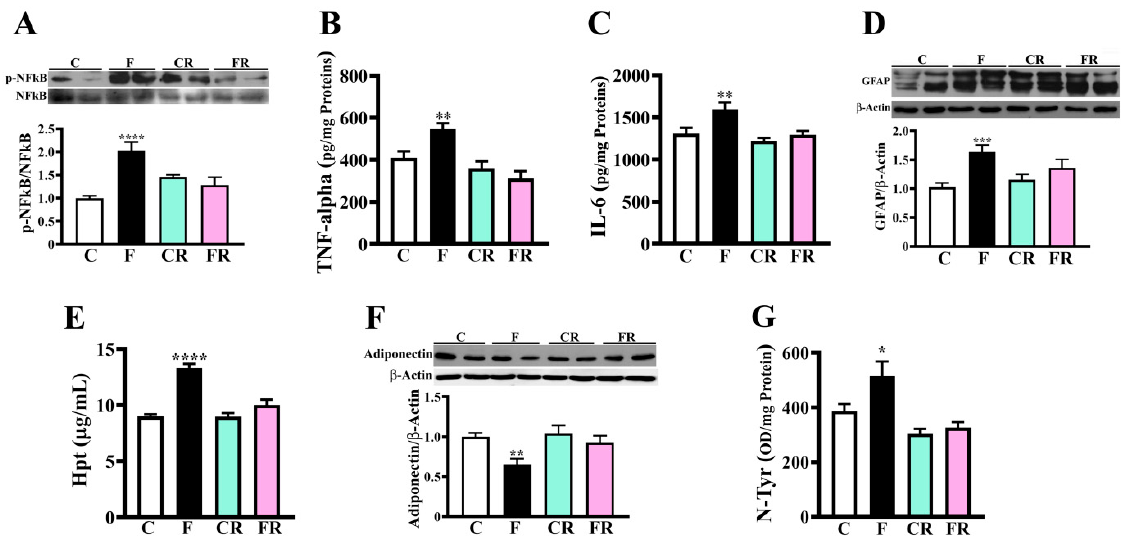
Figure 5. Evaluation of inflammatory and oxidative status in rat hypothalamus. ( A ) p-NFkB/NFkB ra- tio (representative western blotting and densitometric analysis). Samples were analyzed by 10% SDS-PAGE and western blotting. After rivelation of the immunocomplexes (by mouse anti-phosphoNFkB and GAM-HRP IgGs), the membrane was stripped and treated with mouse anti-NFkB and GAM-HRP IgGs. The amount of phosphorylated NFkB was expressed relative to the total NFkB level. Data shown are means ± SEM of eight animals from each group. ( B ) TNF-alpha and ( C ) IL-6 amount was titrated by sandwich ELISA on samples diluted 1:25 and following the manufacturer’s instructions. Data are expressed as pg per mg of total proteins and reported as means ± SEM of eight different rats from each experimental group. ( D ) GFAP amount (representative western blotting and densitometric analysis). Samples were analyzed by 12.5% SDS-PAGE and western blotting. After the rivelation of immunocomplexes (by rabbit anti-GFAP and GAR-HRP IgGs), the membrane was stripped and re-incubated with anti- β -actin. Data shown are means ± SEM of eight animals from each group. ( E ) Hpt level was titrated by ELISA in samples diluted 1: 2000, 1:8000 and 1:25,000. Immunode- tection was carried out with rabbit anti-Hpt and GAR-HRP IgGs. Data are means ± SEM of eight animals from each group. ( F ) Adiponectin amount (representative western blotting and densitometric analysis). Samples were analyzed by 12.5% SDS-PAGE and western blotting. After rivelation of the immunocomplexes (by rabbit anti-adiponectin and GAR-HRP IgGs), the membrane was stripped and re-incubated with an-